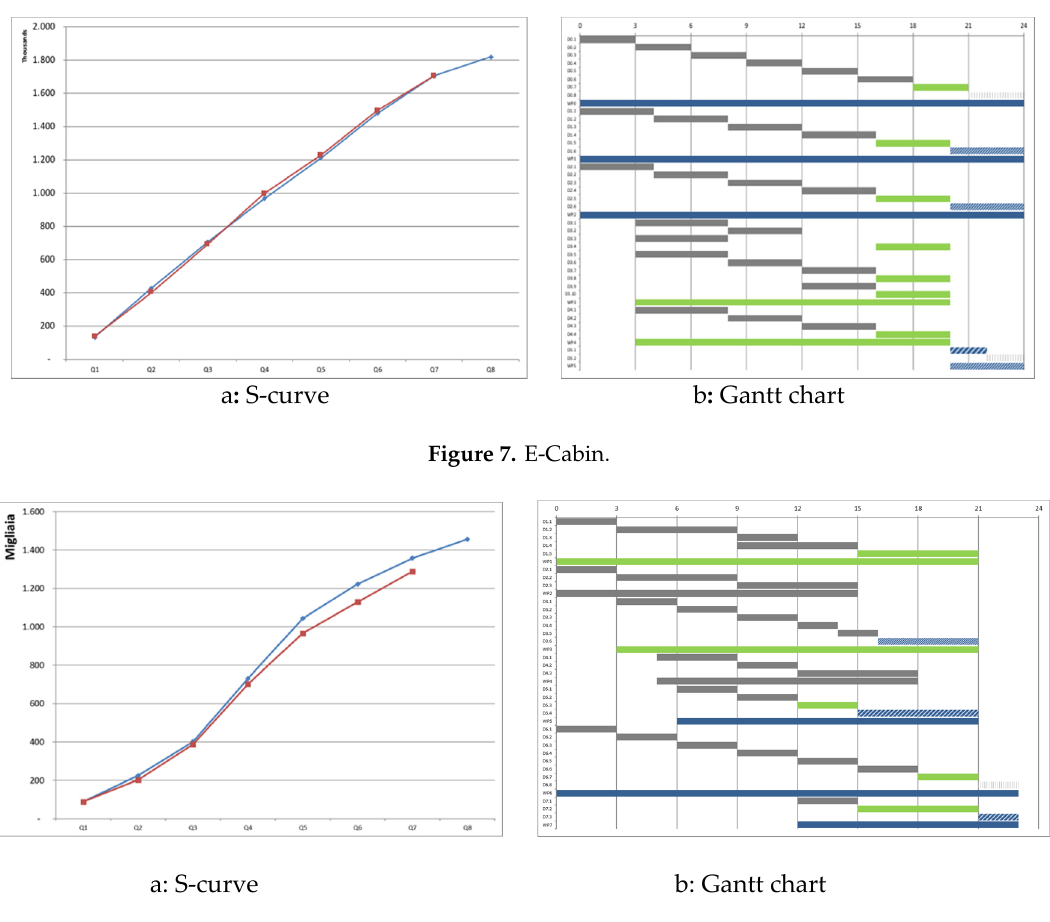
Figure 6. E-Navigation.